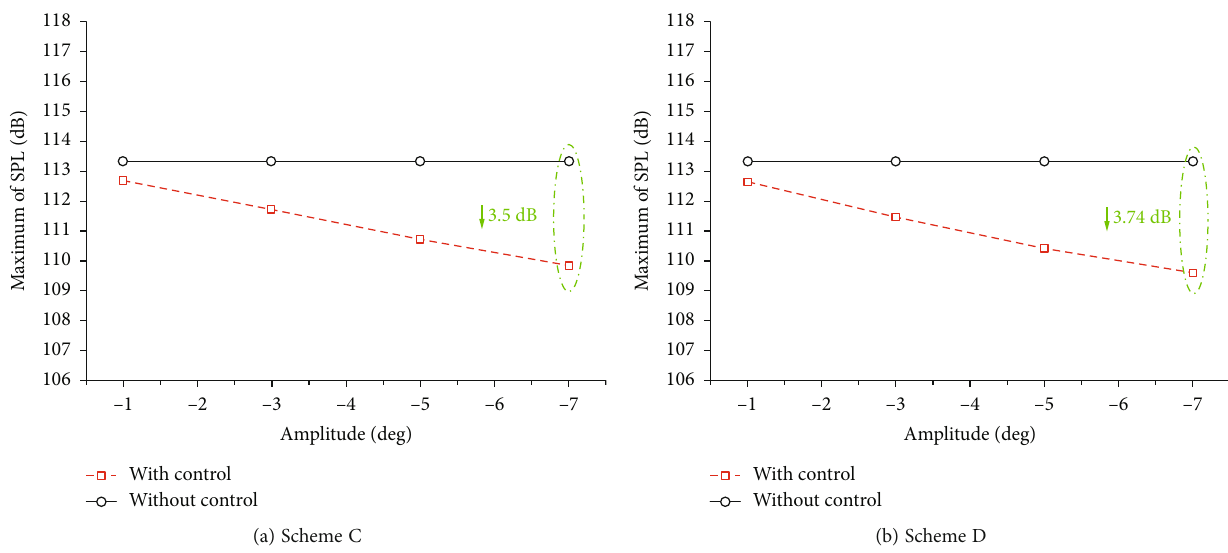
Figure 16: E ff ect of fl ap third local nonharmonic inputs in the third quadrant on maximum SPL of the noise from